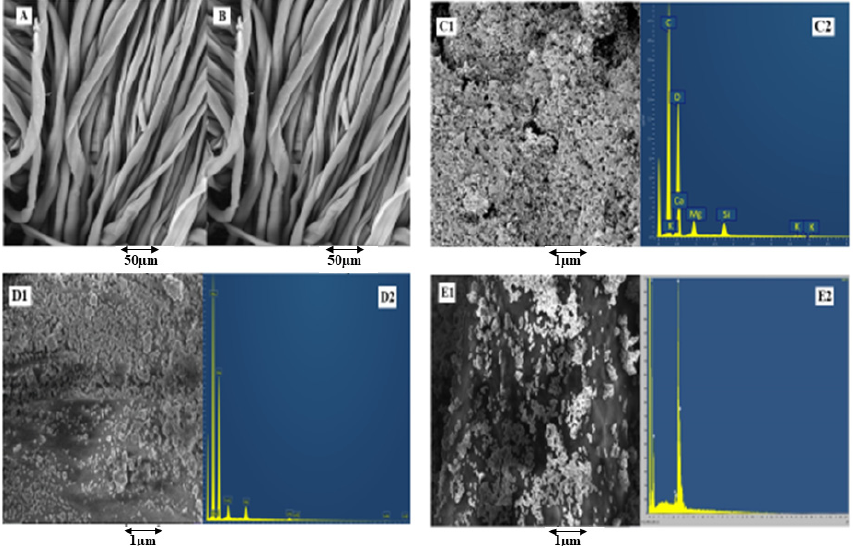
Figure 8. SEM analysis of ( A ) untreated cotton, ( B ) cotton treated with citric acid, ( C1 ) phytochemicals-coated, ( D1 ) copper particle-coated, and ( E1 ) silver particle-coated cotton fibres, with EDX spectra of ( C2 ) phytochemical-coated, ( D2 ) copper particle-coated, and ( E2 ) silver particle-coated cotton fibres.